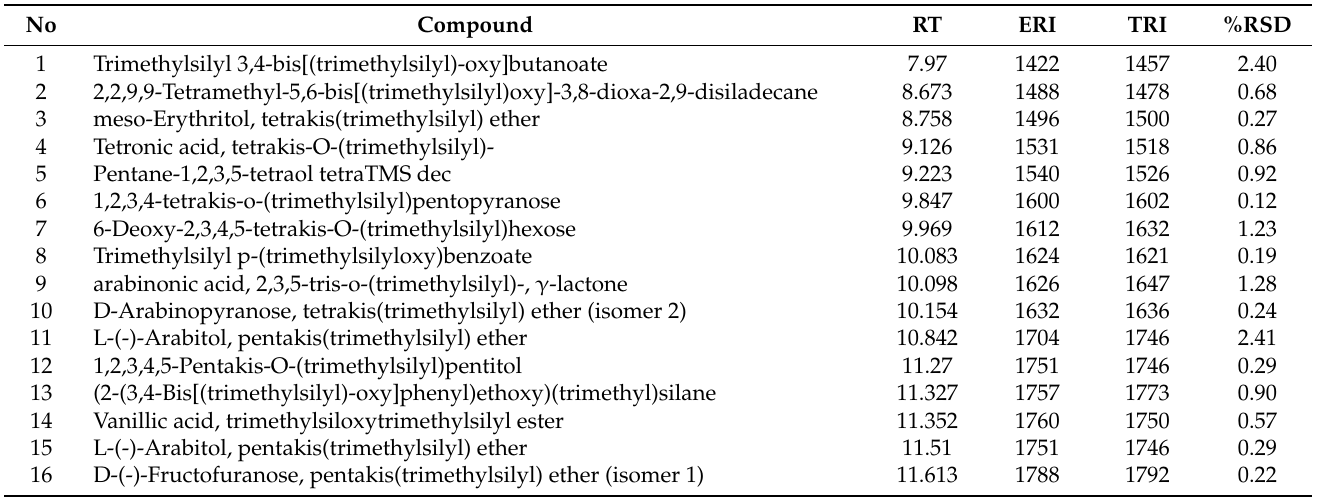
Table 1. Main compounds found in